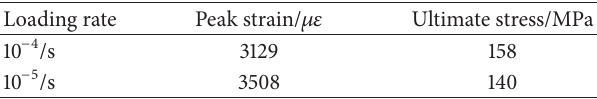
Table 3: Characteristic parameters of compressive stress-strain curves of RPC200.